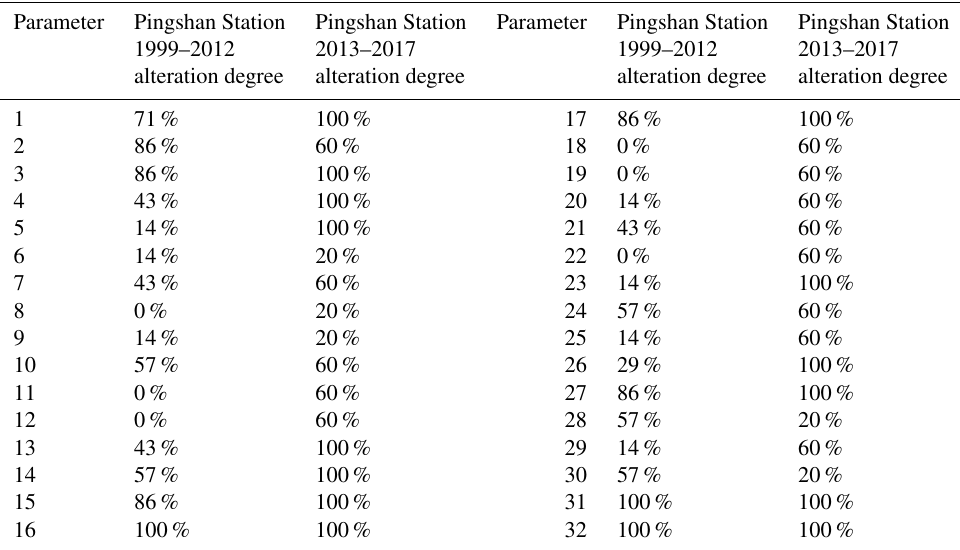
Table 5. Alteration degree of 32 indicators in Pingshan Station in different periods. Parameter